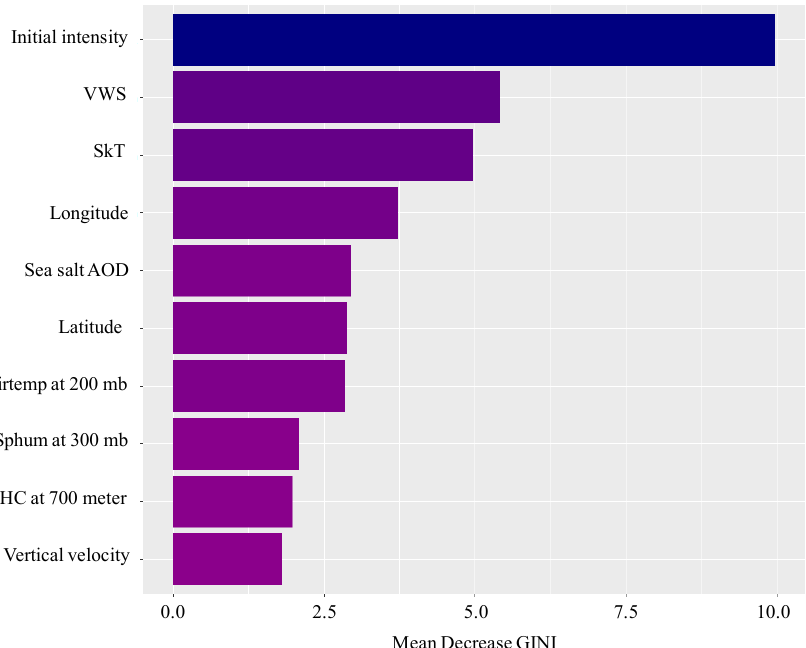
Figure 9. Island LOOCV ROSE sampling technique. Contribution of variables in classifying TC intensification and weakening prior to landfall. The color gradient of the bars is based on the importance of each variable.